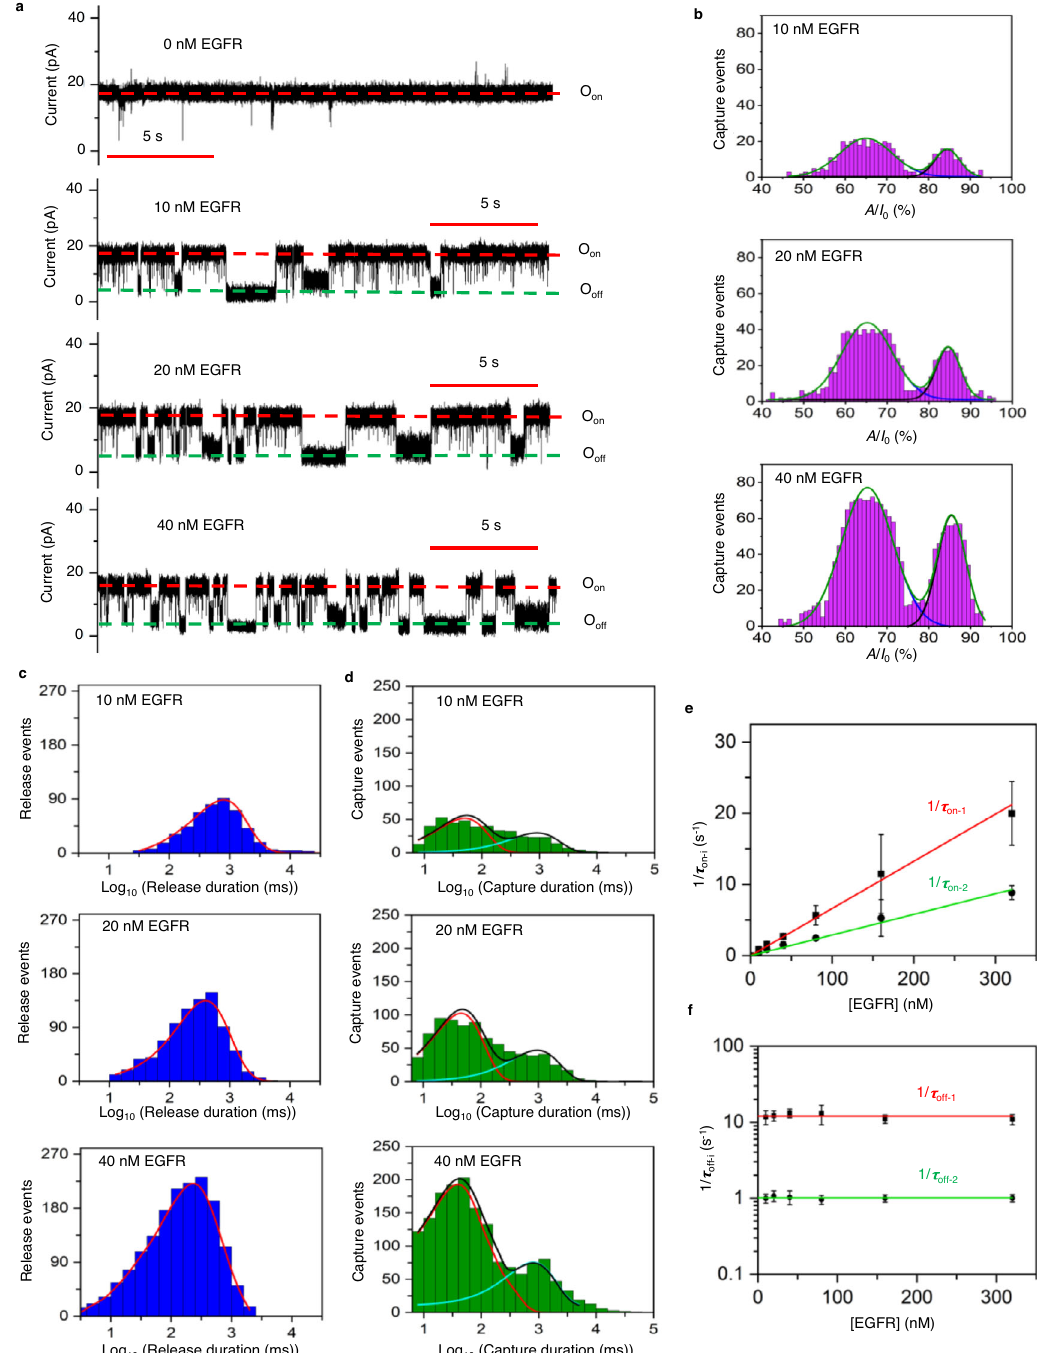
Fig. 4 | EGFR exhibits a bimodal protein recognition. a Single-channel traces (in black)ofAdnectin1-tFhuAinthepresenceofEGFR,whichwere fi lteredat2kHz.O on and O off are the EGFR-released and EGFR-captured substates, respectively. These traces were replicated in n =3 independent experiments. The transmembrane potential was +20mV. b Event histograms (in magenta) of the normalized current blockades A / I 0 ,where A and I 0 aretheamplitudeofblockadesandtheamplitudeof the O on substate, respectively. The cumulative fi ts are marked in green. The blue and black curves indicate fi ts of low- and large-amplitude blockades, respectively. For 10nM EGFR, these values (mean±s.e.m.) were (65.0±0.3)% and (84.50.3)%, respectively (number of events, N =467). For 20nM EGFR, they were (65.2±0.2)% and (85.1±0.2)%, respectively ( N =924). For 40nM EGFR, they were (65.3±0.2)% and (85.5±0.2)%, respectively ( N =1711). c Histograms (in blue) of the EGFR- releaseddurations ( τ on )atvariousEGFRconcentrations,[EGFR]. τ on (mean±s.e.m.) were 0.78±0.04s (number of events: N =491), 0.42±0.03s ( N =843), and